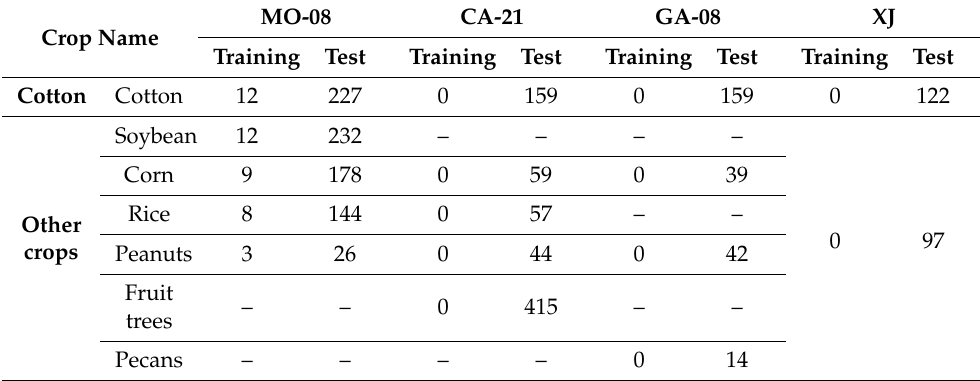
Table 3. Training and test samples used in four study